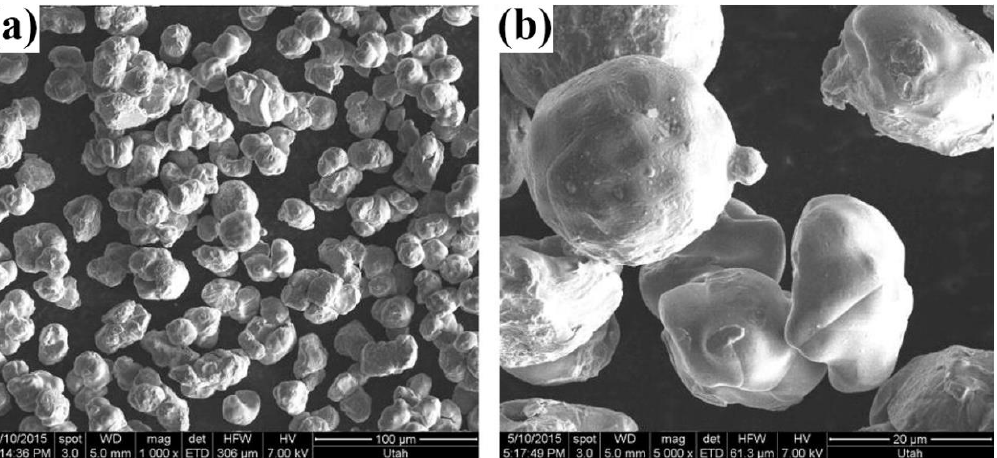
Figure 9. SEM images of titanium powder produced by HAMR process: ( a ) 1000×; ( b ) 5000× [73] (Adapted from [73], with permission from Elsevier, 2016). (Adapted from [73], with permission from Elsevier,